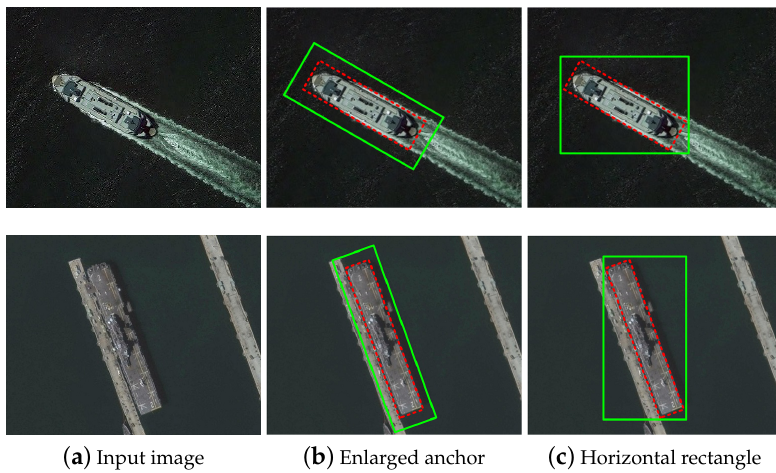
Figure 7. ( a ) is the input image. In ( b ), enlarged rotated anchor box (the green rectangle) is used to extract the features containing context information. However, this way is relatively complicated. In this paper, we use horizontal minimum bounding box (the green rectangle in ( c )) of the original rotated anchor (the red rectangle in ( c )) to extract features containing context